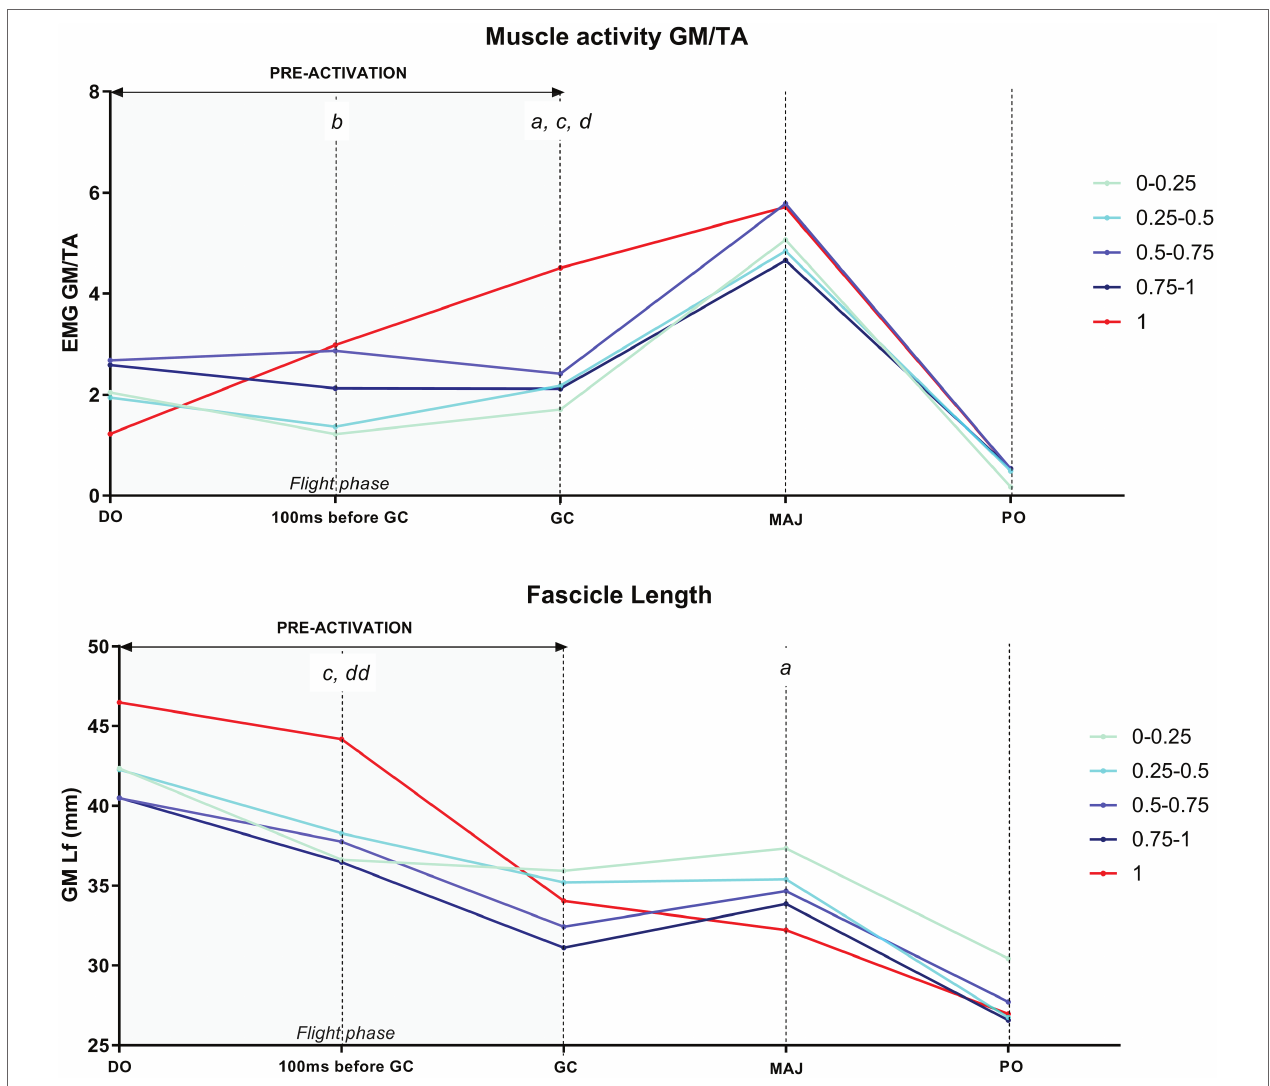
FIGURE 8 | Time course of the gastrocnemius medialis/tibialis anterior (GM/TA) EMG and fascicle length (Lf) during the five drop jump time points – drop-off (DO), 100 ms before ground contact (GC), GC, MAJ, push-off (PO) – in hypo-gravity (0–0.25 g, 0.25–0.5 g, 0.5–0.75 g, and 0.75–1 g) and 1 g. Results shown as grand means of maximum three jumps per gravity level per subject. GM Lf at 110 ° (bipedal standing on the platform) was 57.4 mm. GM at DO ranged from 46.5 mm (1 g, 130.4 ° ankle angle) to a minimum of 40.5 mm (137.1 ° ankle angle). a p < 0.05 1 g vs. 0–0.25 g; b p < 0.05 1 g vs. 0.25–0.5 g; c p < 0.05 1 g vs. 0.5–0.75 g; d p < 0.05 1 g vs. 0.75–1 g; dd p < 0.01 1 g vs. 0.75–1 g.